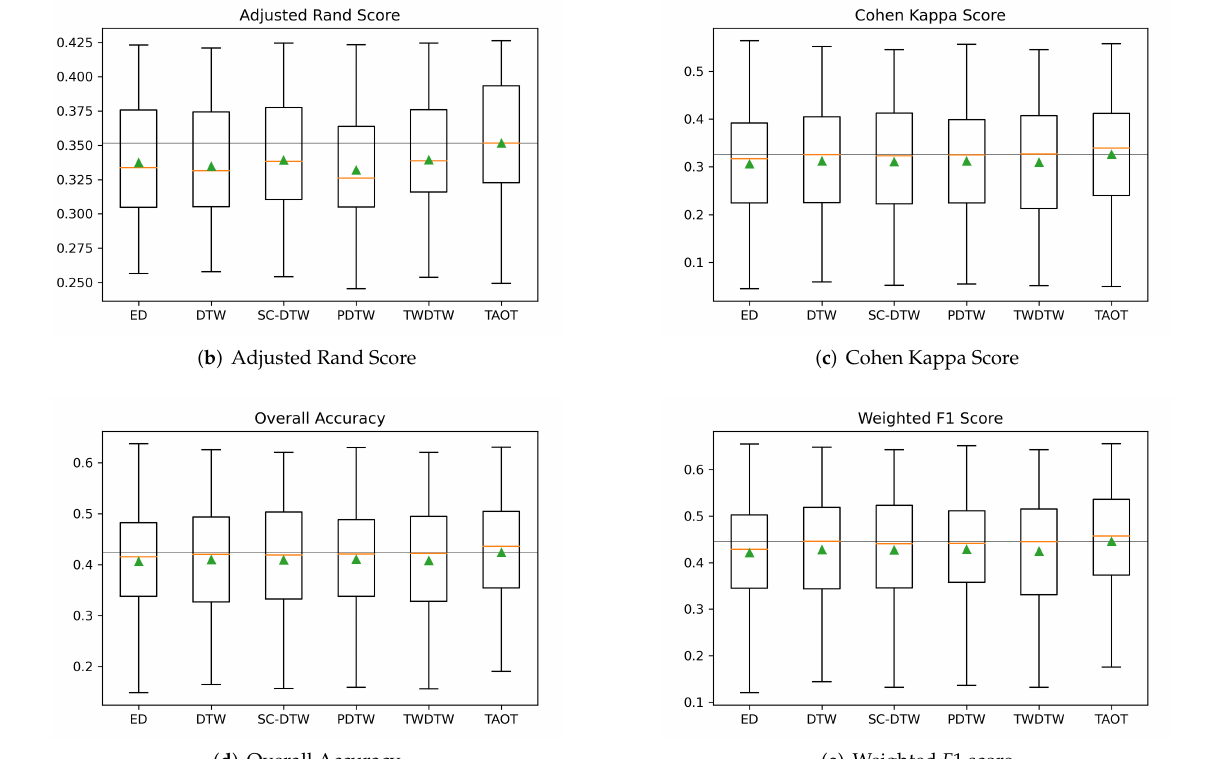
Figure 6. Distribution of each performance metric over the 100 repetitions performed on the Reunion Island dataset. The orange line indicates the median and the green triangle indicates the mean. The gray line locates the mean value of TAOT for reference. ( a ) Adjusted Rand Score; ( b ) Cohen Kappa Score; ( c ) Overall Accuracy; ( d ) Weighted F 1 score.